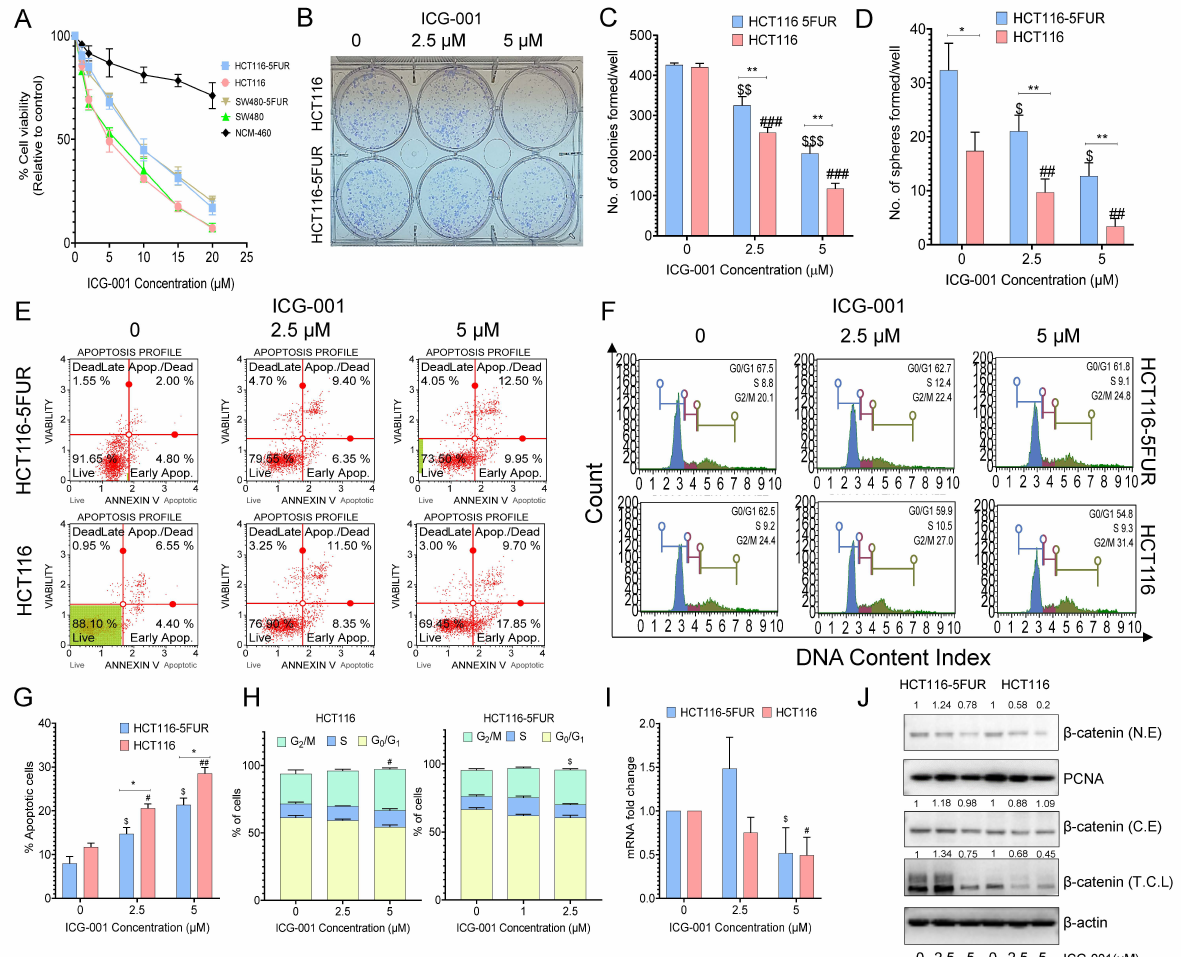
Figure 3. Anti-proliferative effects of the Wnt signaling inhibitor ICG-001 in parental and 5FUR CRC cells. ( A ) Measurement of percent cell viability after treatment with ICG-001 (1–20 mM) for 48 h in parental and 5FUR CRC cells by CCK-8 assay. ( B ) Representative images of colonies and ( C ) the number of colonies formed after treatment with different concentrations of ICG-001 for 48 h. ( D ) Sphere-formation capacity after treatment with ICG-001 for 48 h. ( E ). Representative histogram of the percentage of apoptotic cells and ( G ) a graphical representation of the percentage of apoptotic cells after treatment with different concentrations of ICG-001 in parental and HCT116-5FUR cells for 48 h. ( F ) Representative histograms of different phases of the cell cycle and ( H ) a graphical rep- resentation of the percentage of cells in different phases of the cell cycle after treatment with differ- ent concentrations of ICG-001 for 48 h. ( I ) Gene and ( J ) protein expression analyses of β -catenin in parental and HCT116-5FUR cells after treatment with ICG-001 for 48 h (N.E-nuclear extract, C.E- cytoplasmic extract, T.C.L-total cell lysates). Original blots see File S1. Statistical significance was determined by a Student’s t -test. (Comparison between Parental vs. 5FU-resistant group-* p < 0.05, ** p < 0.01; comparison between Control and treatment groups for HCT116- $ p < 0.05, $$ p < 0.01, $$$ p < 0.001; comparison between Control and treatment groups for HCT116-5FUR- # p < 0.05, ## p < 0.01, ### p < 0.001.)